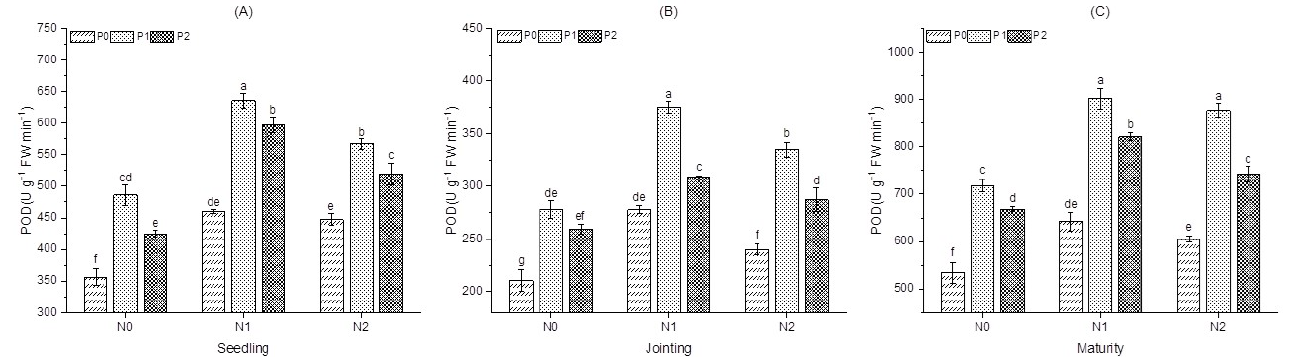
Figure 1. Effects of nitrogen and phosphorus on superoxide dismutase (SOD) activity of sorghum plants grown in saline soils at the three growing stages of seedling, jointing, and maturity. ( A ) Seed- ling stage; ( B ) Jointing stage; ( C ) Maturity stage. Within each sampling date, the data followed by different letters are statistically different at the 0.05 probability level.